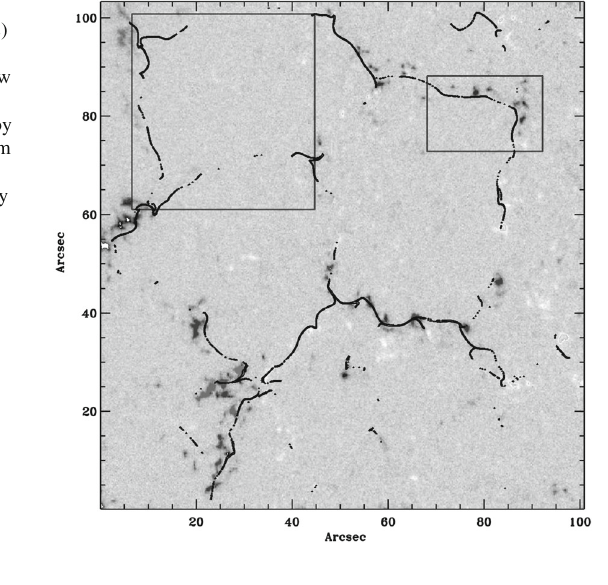
Fig. 7 Distribution of magnetic field intensity (grey scale levels) on the supergranulation boundaries. The black dots show the final positions of floating corks that have been advected by the velocity field computed from the average motion of granules. The distribution of corks closely matches that of the magnetic field. Image reproduced with permission from Roudier et